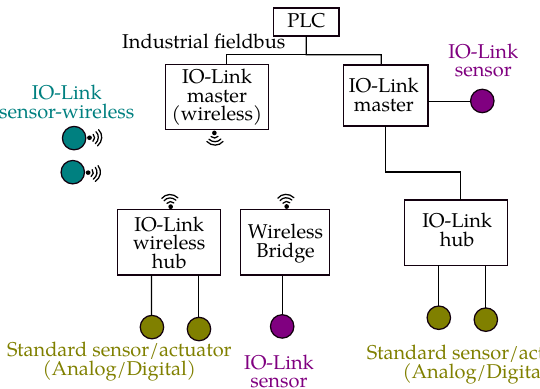
Figure 2. IO-Link system architecture